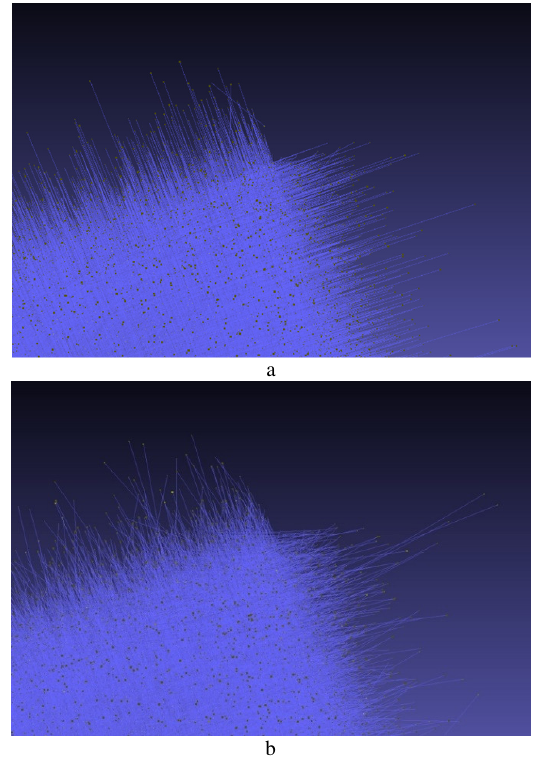
b Figure 11. Simulated normal noise on the box 3D data: a) no noise; b) Gaussian random noise of 20% of the original orientation